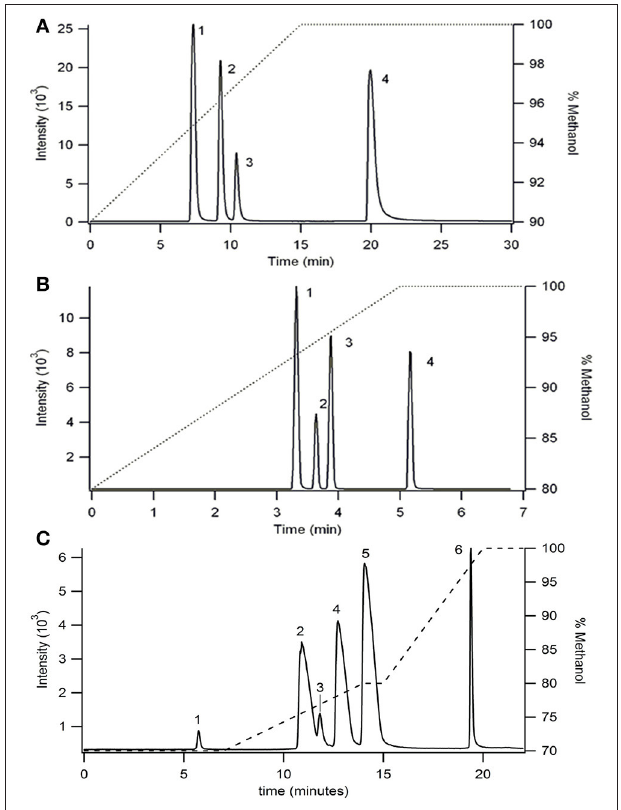
FIGURE 2 | Separation of NAGs on (A) a C30 YMC carotenoid column (4.6 × 150mm, 5um particles size) and (B,C) Phenomenex C18 column (4.6 × 100mm, 2.6 µ m particles size) using two different gradient separations. Ionized by ESI and detected in MRM mode as the [M − H] − parent and 74 m/z glycine head group product at collision energy of 20 V. Flow rate was 1 mL/min. The right axis shows the gradient elution profile for % methanol.